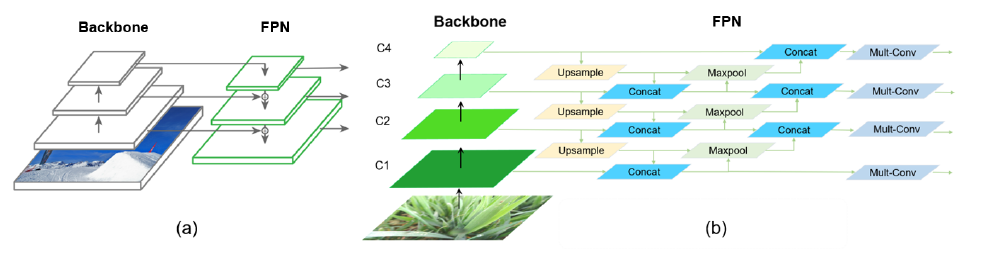
Figure 4. Original model and improved model structure: ( a ) FPN structure of RetinaNet; ( b ) our improved